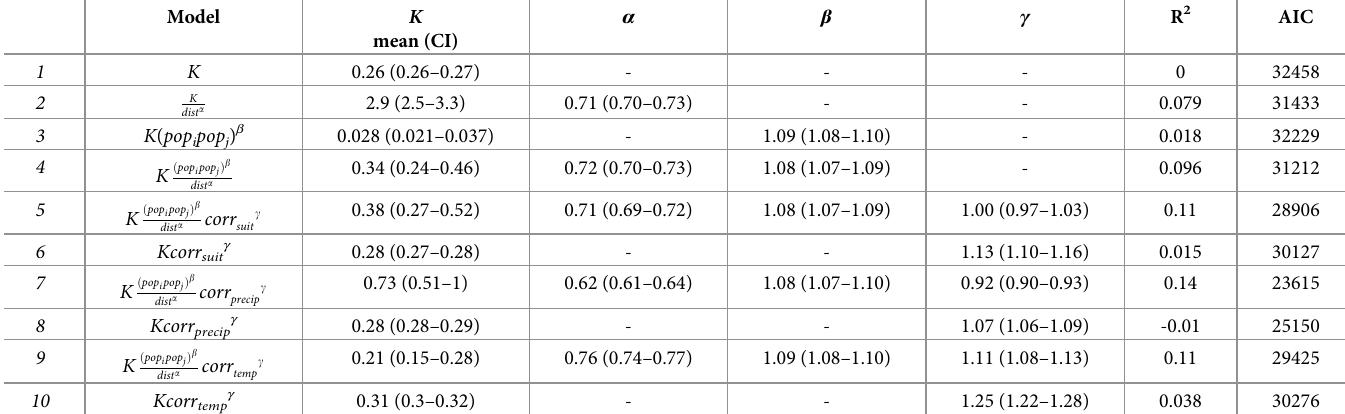
Table 1. Gravity style model fitting for epidemic synchrony between Urban-2 regions.